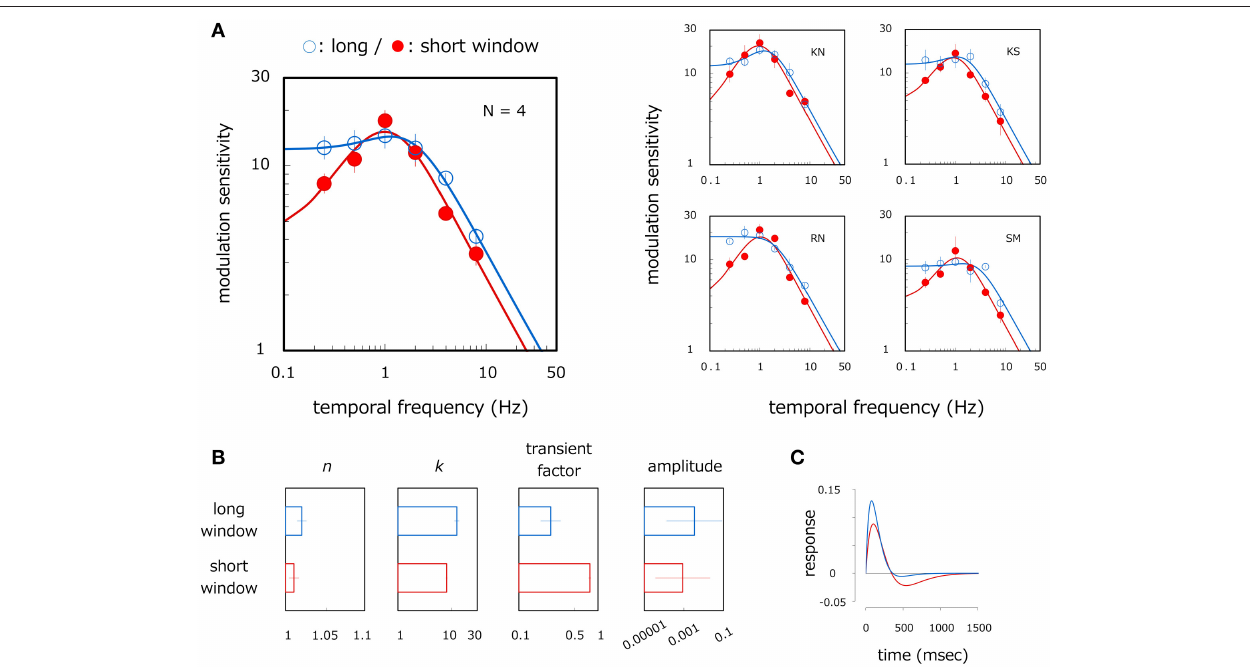
FIGURE 2 | Results of Experiment 1. (A) Velocity modulation sensitivity for grating stimuli of different window sizes. Left panel shows results averaged across observers and right panels show those for each observer. Open and filled circles show modulation sensitivity as a function of the temporal frequency of velocity modulation for long- and short-window conditions respectively. Each curve represents the modulation transfer function (MTF) fitted to the plotted data. Error bars represent ± 1 SE across observers or 400 bootstrap samples within observer. (B) Estimated parameters of the MTF for the long- and short-window conditions. Each panel represents n , k , transient factor, and amplitude. Error bars represent ± 1 SE across observers. (C) Temporal impulse response function. Blue and red curves were estimated with the inverse Fourier transform of the MTF fitted to the mean data in the long- and short-window conditions respectively. The ordinate represents relative strength of system response where positive and negative values correspond to excitatory and negative response